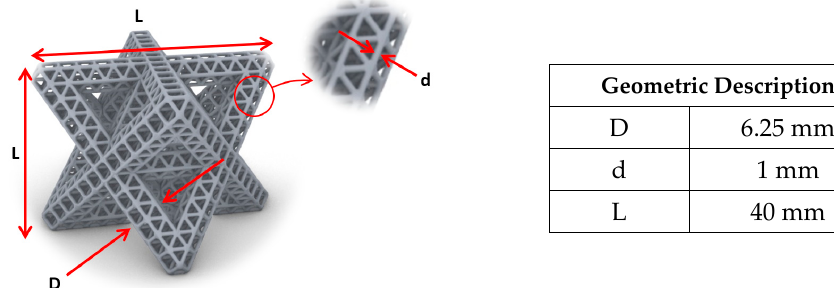
Figure 2. Geometric description of a hierarchical lattice.